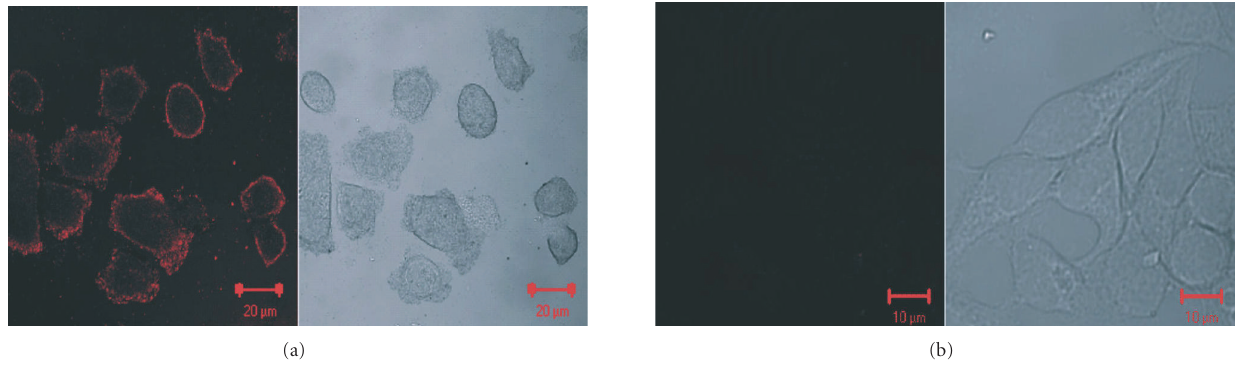
Figure 8: Corresponding images as in Figure 7 for bioconjugates consisting of silver-stained HER81/gold nanorod conjugates incubated with (a) SKBR3 cells and (b) CHO cells. Care was taken to maintain the same acquisition parameters in both cases. The bioconjugates are accumulated at the cell membranes of SKBR3 cells where HER2 is localized. As expected, no such accumulation takes place in the case of HER2 negative CHO cells.